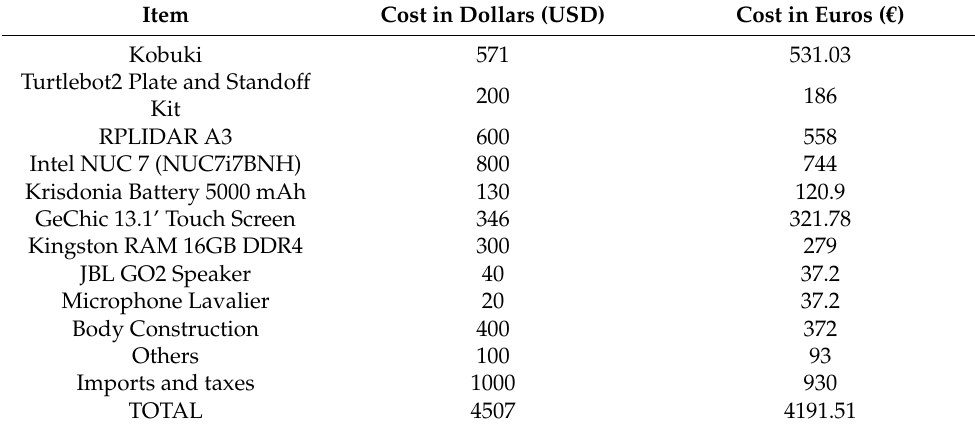
Table 7. Price Table.